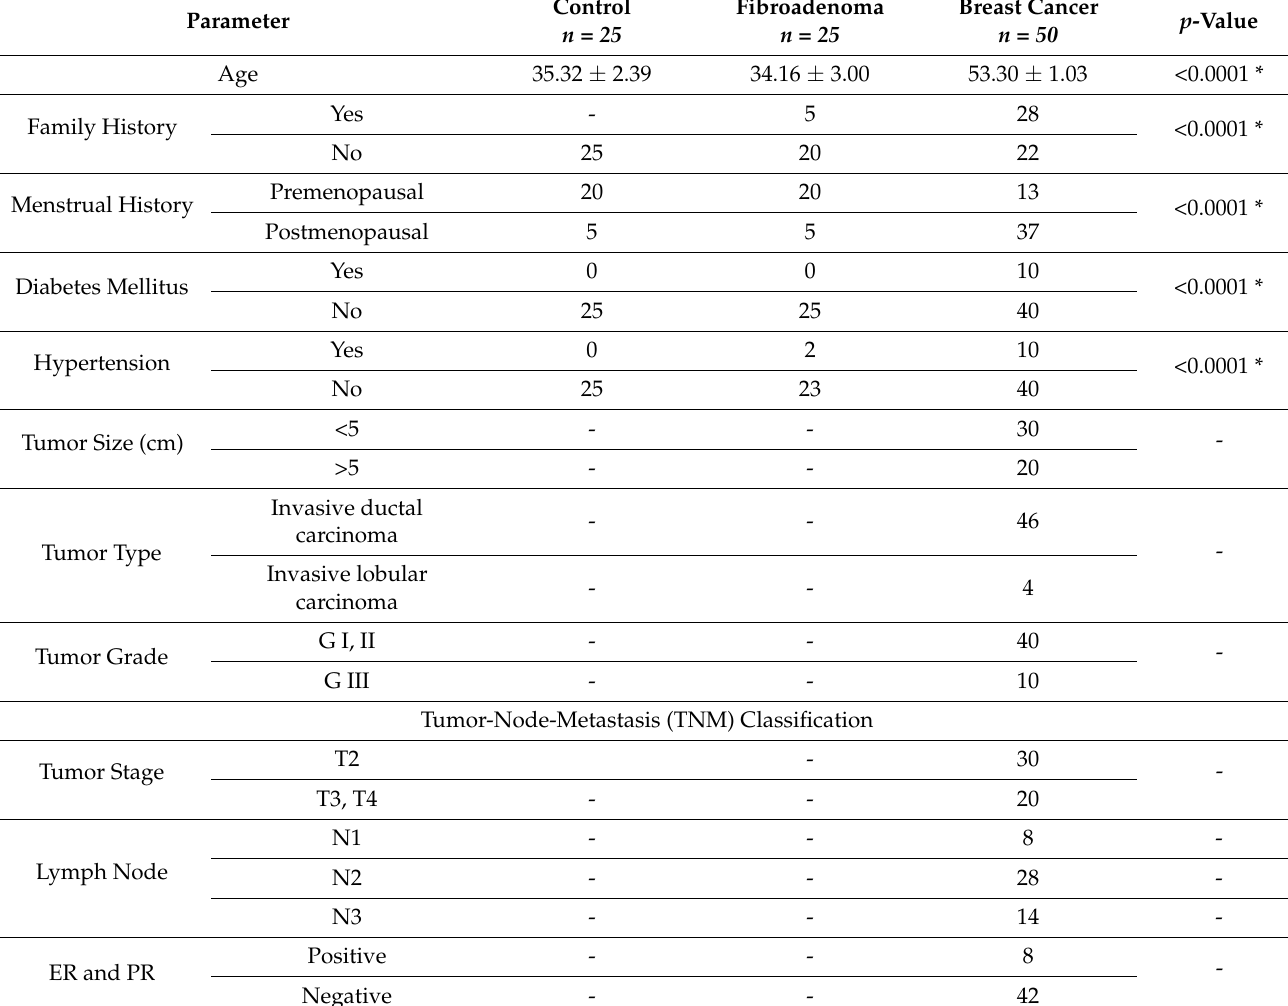
Table 2. Demographic profile of the control, fibroadenoma, and the breast cancer